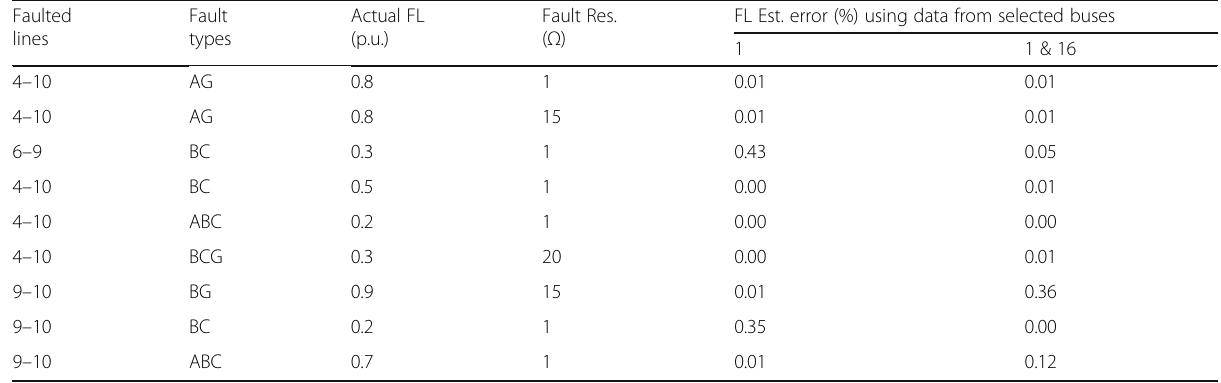
Table 6 Fault location results for single faults on transposed lines Faulted lines